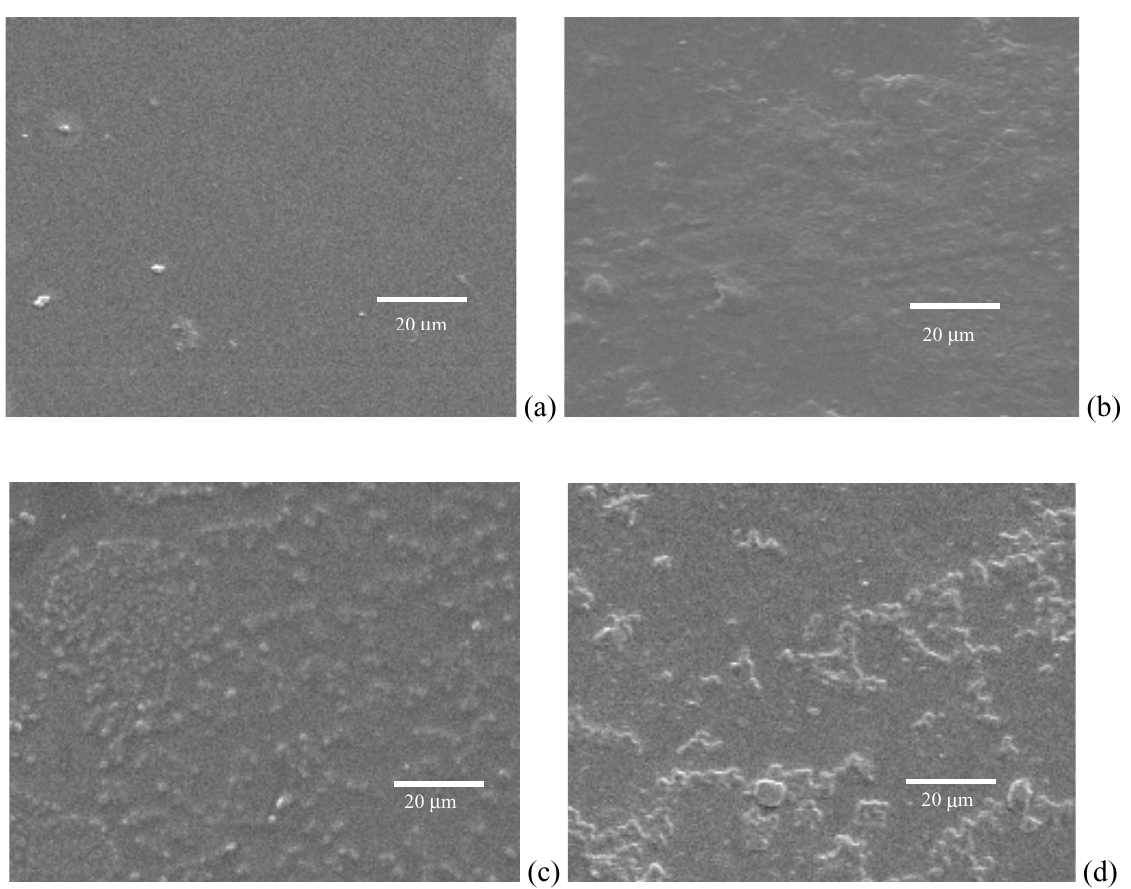
Figure 14. SEM images of the polyurethane layer surfaces for (a) the sensor in air, (b) the sensor in water for 4 days, (c) the sensor in a bacteria culture for 2 days, and (d) the sensor in a bacteria culture for 4